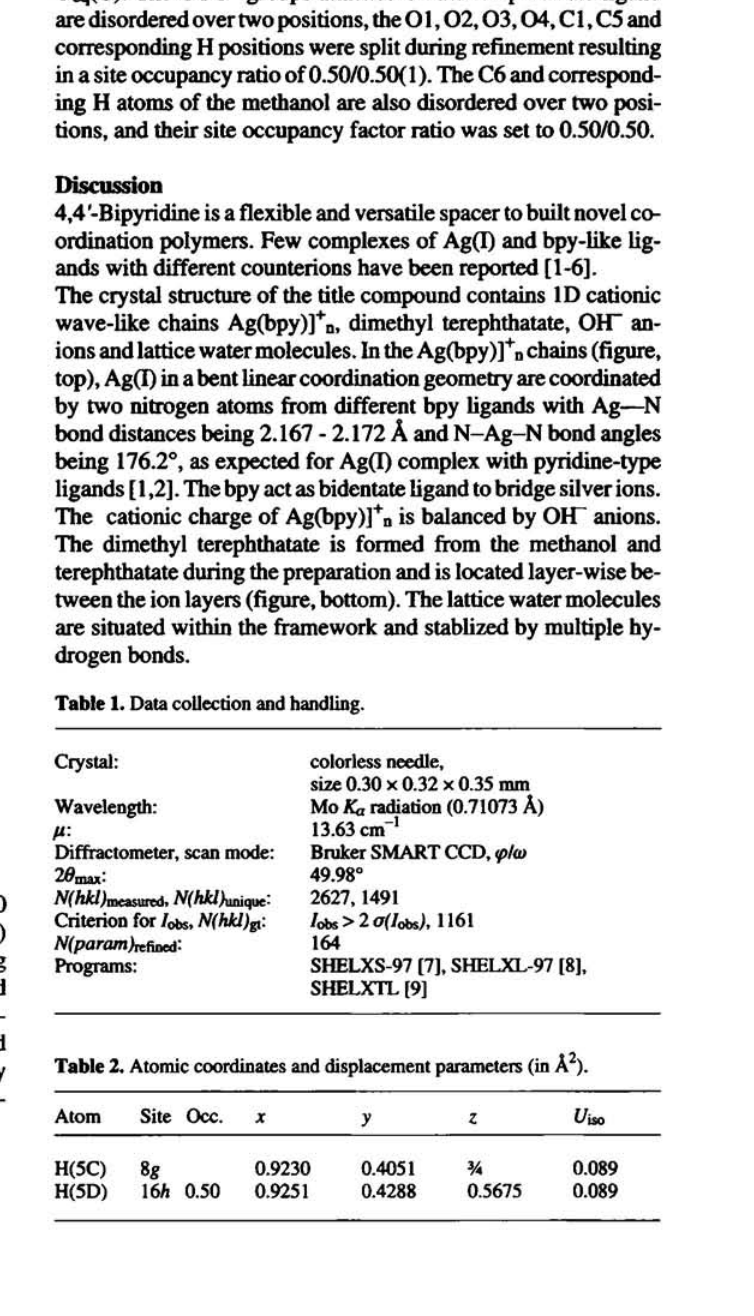
Table 2. Atomic coordinates and displacement parameters (in Â 2